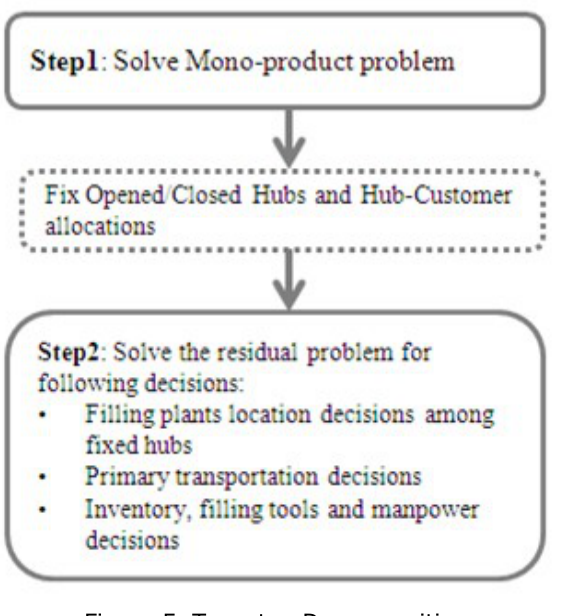
Figure 5. Two-step